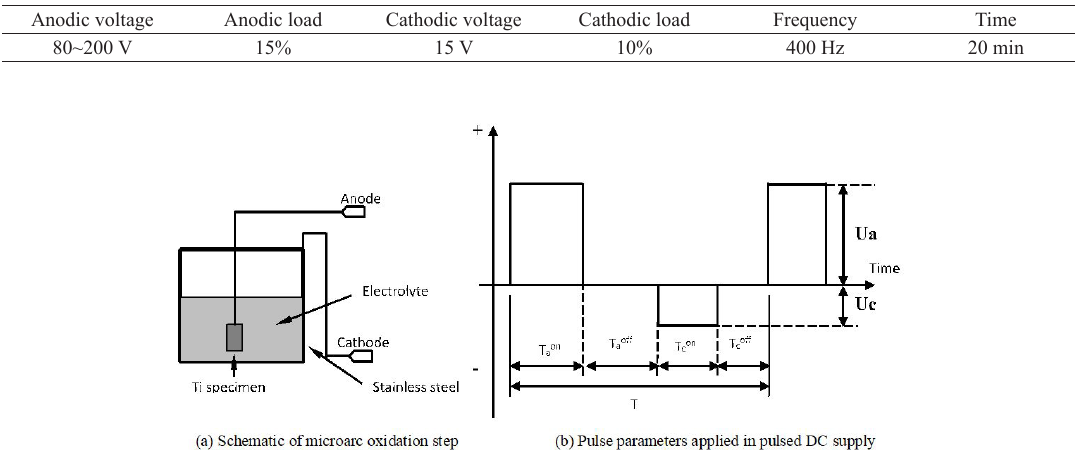
Table 1. Parameters applied in the MAO treatments.